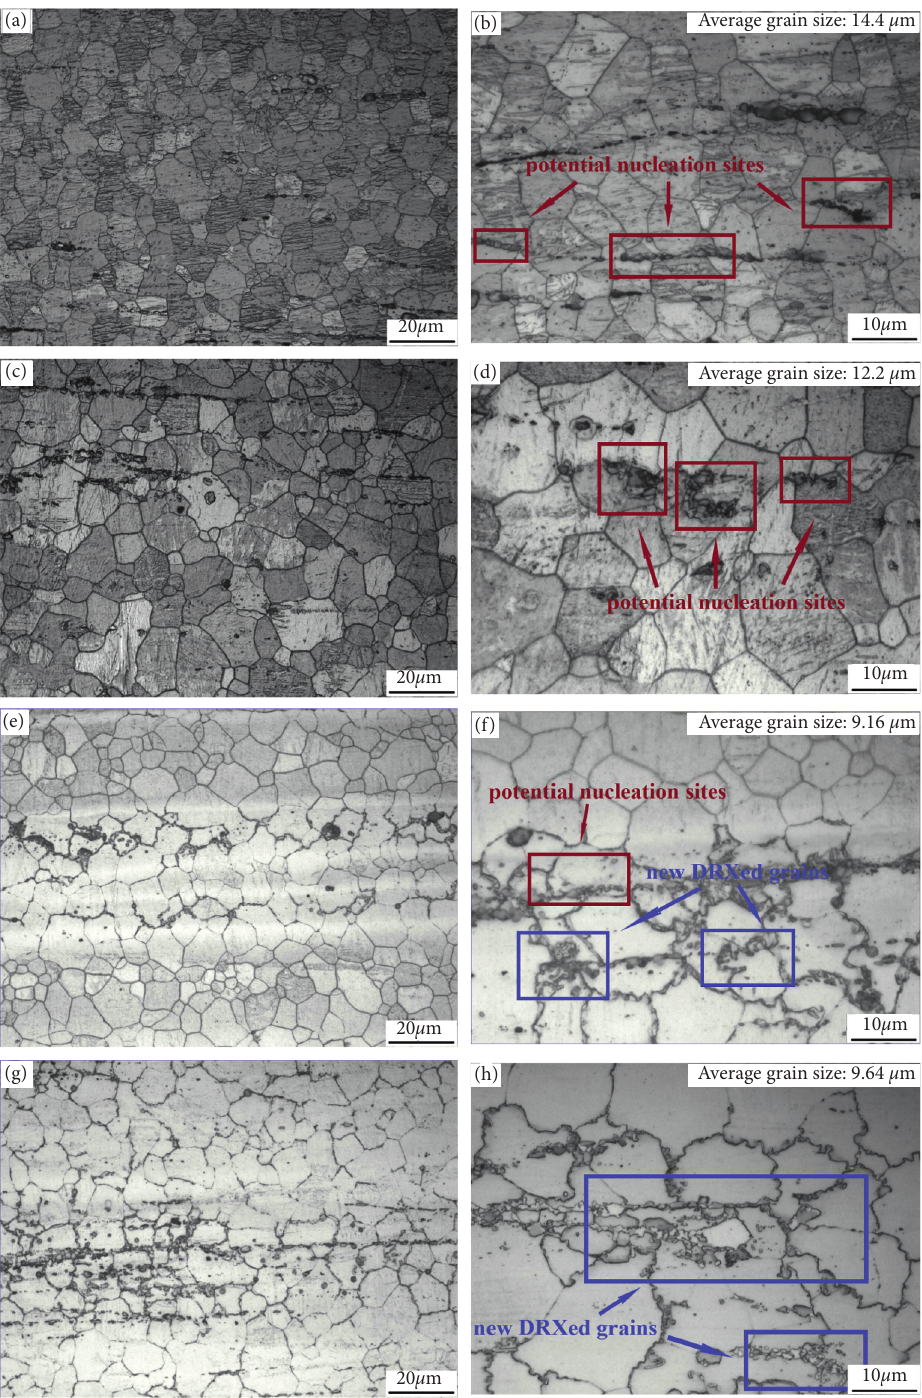
Figure 3: OM images of as-extruded AZ-0.3La alloys: (a, b) AZ01-0.3La.; (c, d) AZ31-0.3La; (e, f) AZ61-0.3La; and (g, h)